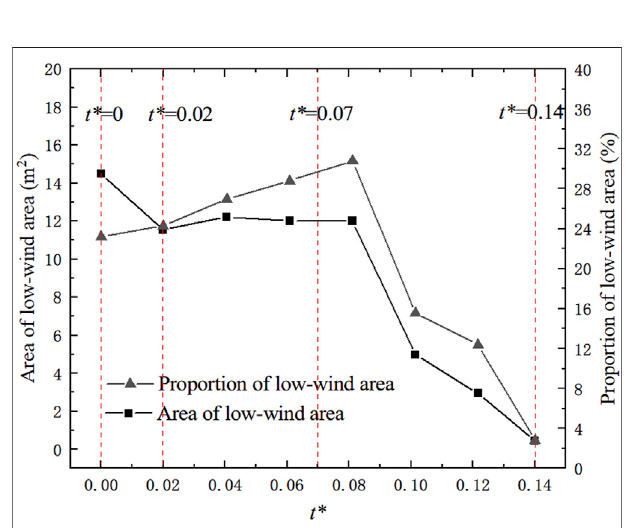
FIGURE 9 | Low-wind area around the cutting. The formation of drifting snow disasters is correlated with low-wind speed areas. It is observed from the simulation results that the location of the snow cover is related to the area where the wind speed is less than 1 m/s. Therefore, changes in the low- wind speed area within the whole cutting range are analyzed, as shown in Figure8 .Beforethesecondaryvortexdisappears,theproportionoflow-wind speed area